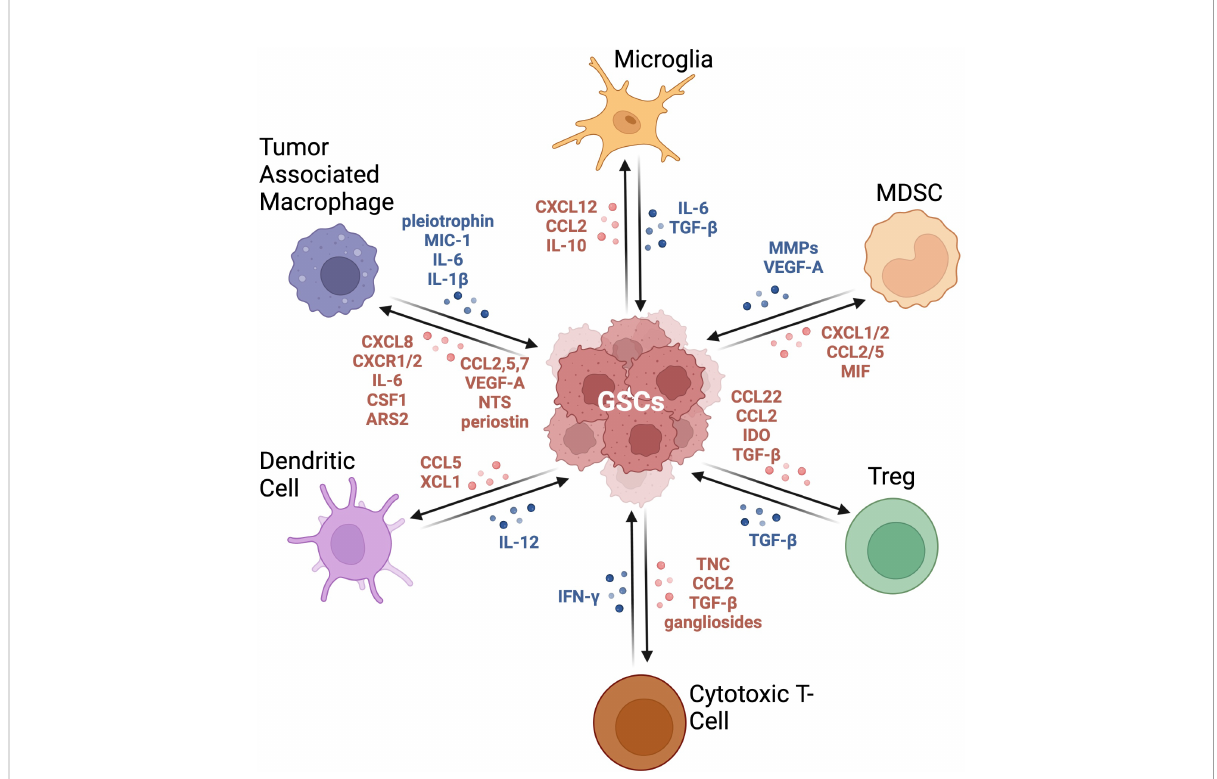
FIGURE 2 Crosstalk between GSCs and immune cells in the GBM TME. This graphic demonstrates the bidirectional relationship between GSCs and the immune compartment. These signaling pathways result in immune cells producing an immunosuppressive milieu and tumor cells becoming more tumorigenic with increased expression of stemness markers. Adapted from “ Immunosuppressive Cells in the Tumor Microenvironment ” , by BioRender.com (2022). Retrieved from